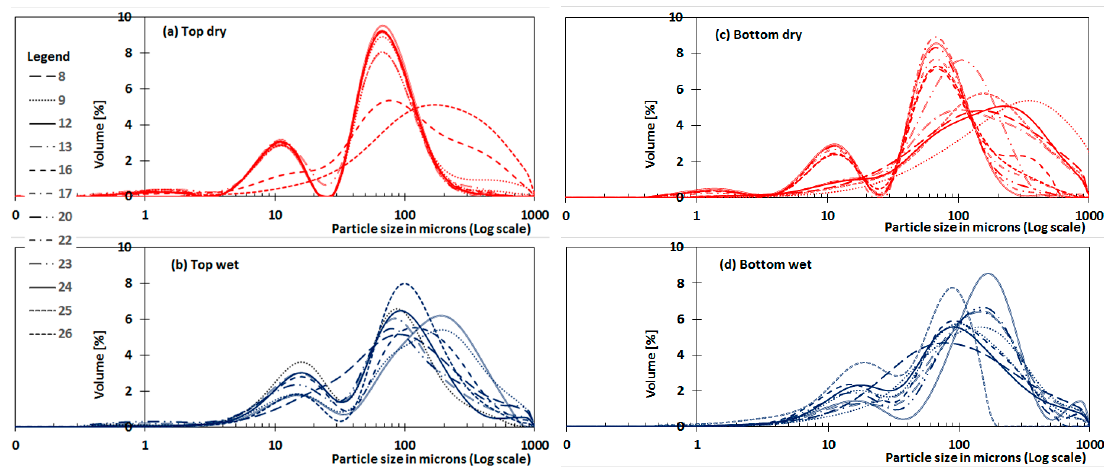
Figure 3. Particle size distribution for the top and bottom samples collected inside the pond (node numbers shown in the legend). ( a , c ) Dry weather top and bottom respectively; ( b , d ) Wet weather top and bottom